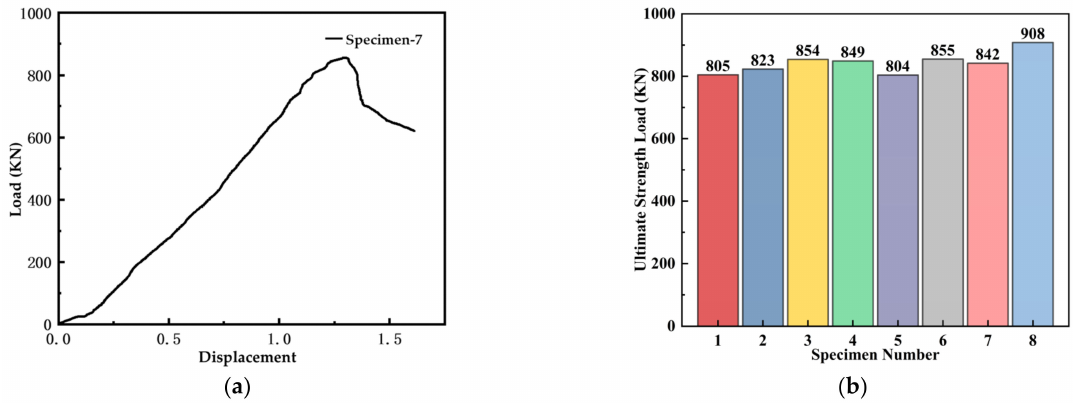
Figure 9. Load–displacement curve and histogram of ultimate strength load ( a ) Load-displacement curve of specimen-7 ( b ) Ultimate strength load of 8 sets of test specimen.